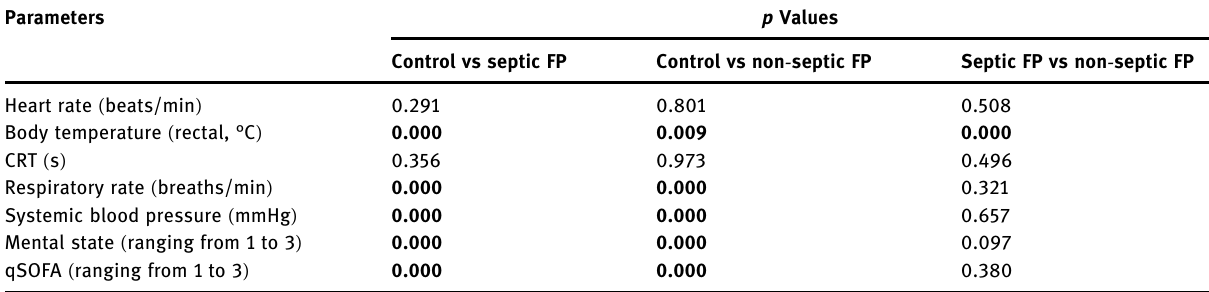
Table 2: p Values of intergroup comparison of physical examination fi ndings and qSOFA scores ( p value < 0.05: bold )